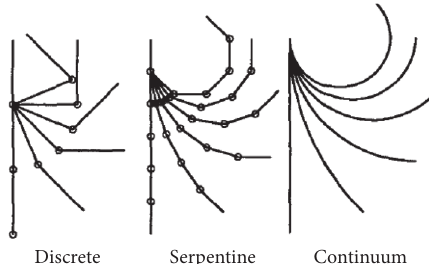
Figure 1: Differentiation—linked and continuum [8]. Table 1: The robots surveyed herein mapped per their